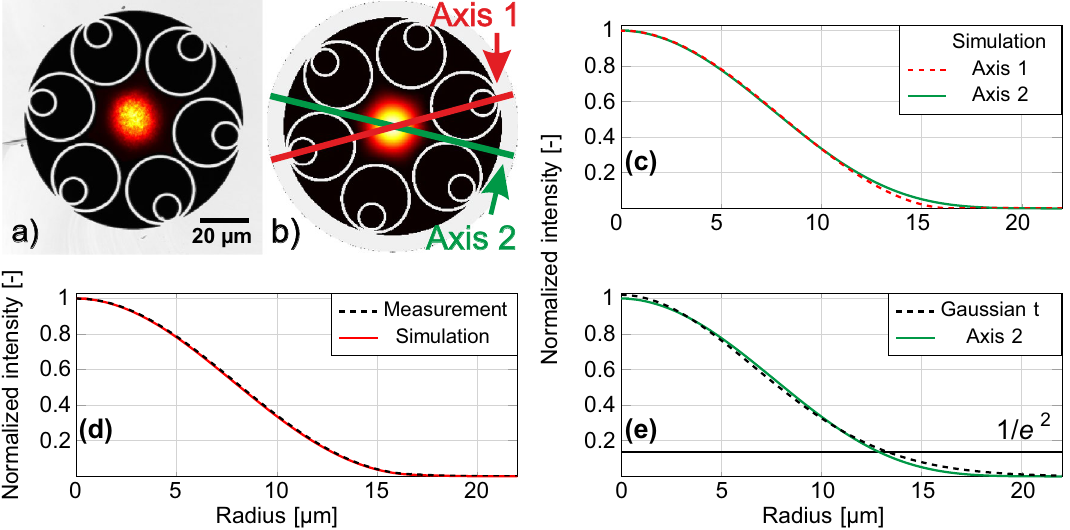
Figure 1. ( a ) Measured mode field distribution at the output of NANF overlaid with the captured image of the NANF core area. ( b ) Simulated fundamental mode field distribution overlaid with the NANF microstructure, extracted from the used NANF end-face photograph. ( c ) Mode field profiles from ( b ) along the two principal axes shown in ( b ). ( d ) Averaged axis 1 and 2 mode field profiles from measurement and simulation. ( e ) Mode field profile from ( c ) and its Gaussian